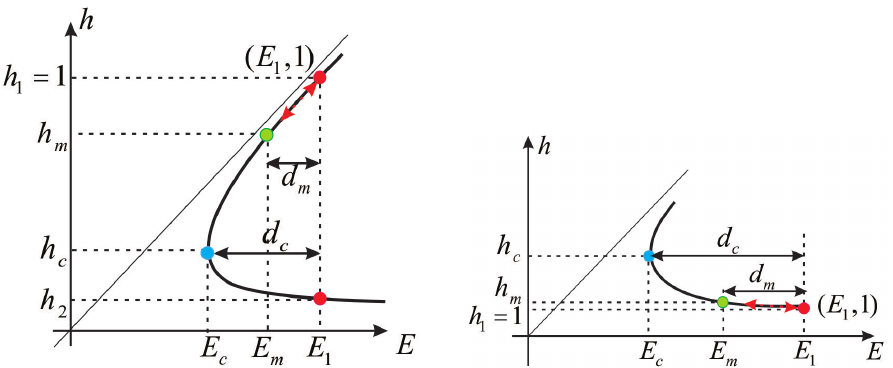
Figure 2. The energy curves E ( h ) , ( left ) the subcritical case, and ( right ) the supercritical